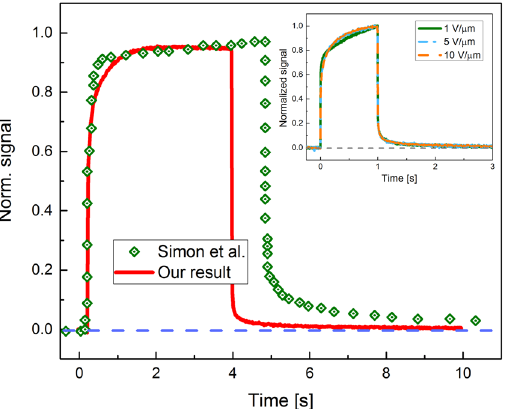
Figure 1. X-ray signal of poly-PbO, measured at F = 4 V/ μ m. The inset shows normalized X-ray signals measured at different exposures. Dark signal I dark is set to